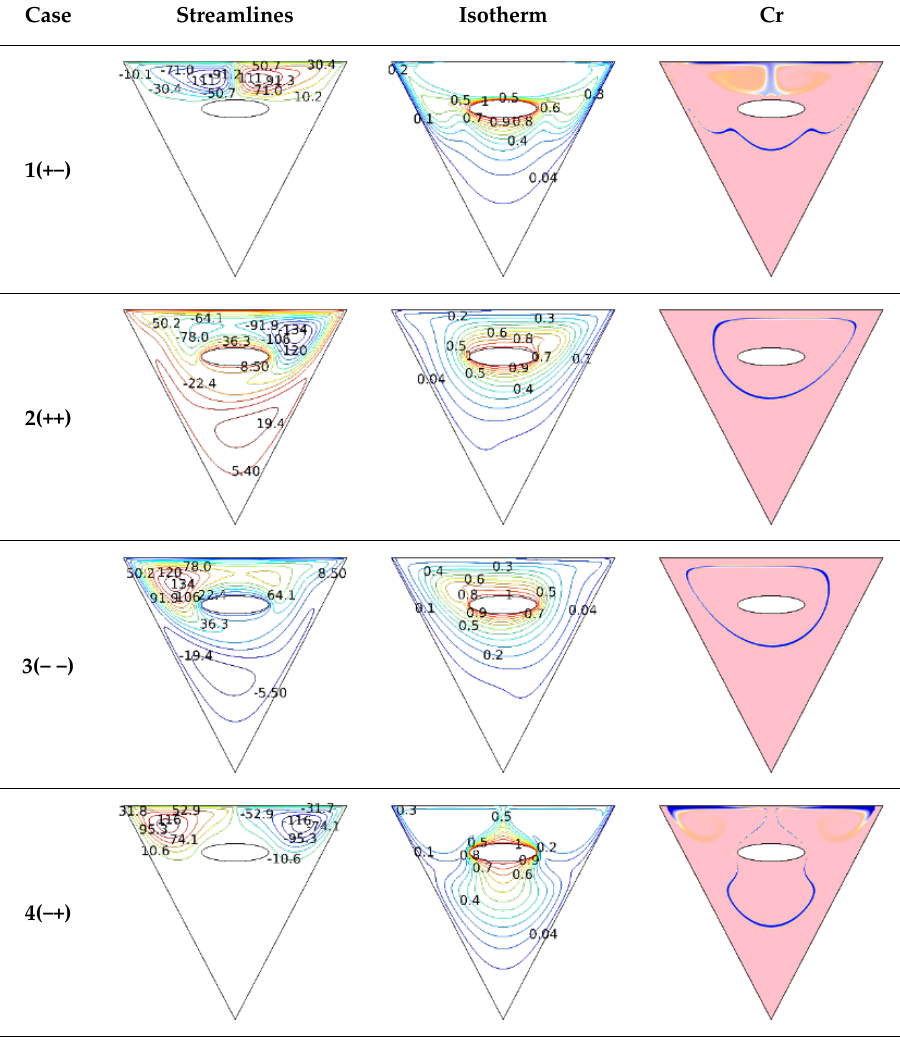
Figure 5. Features of the streamlines ( left ), isotherms ( middle ) and capacity ratio of NECPCM ( right ) for various considered cases. (The negative and positive sign numbers in the streamlines represent the direction and strength of flow, while the numbers in the isotherms mean the heating level.)